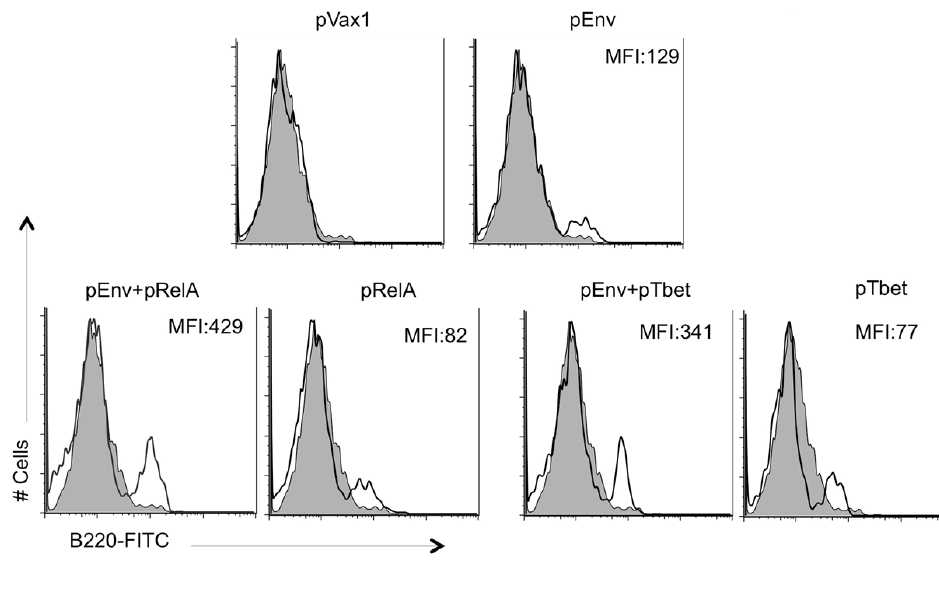
Figure 5. Molecular adjuvants enhance populations of B-cells at the site of immunization. Cells cultures from the muscle were analyzed by flow cytometry for expression of B220. The isolated cells were incubated in culture media for three days and these cells and then stained with DC subsets (CD11c + /CD11b + ), B cells (B220 + ), T cells (CD4 + and CD8 + subsets), to distinguish monocytes/dendritic, B cells, T cells, respectively. Such differential staining allowed the exclusion of dendritic and T cells from subsequent analysis of B220 expression. Histograms show the B220 + expression on B cells exclusively using a specific mAb as well as an isotype-matched, irrelevant mAb as a control. The profile of an isotype-matched irrelevant Ab, used as a control (shaded area) is also indicated in the panels. MFI = mean fluorescent intensity which is proportional to the level of B220 expressing B